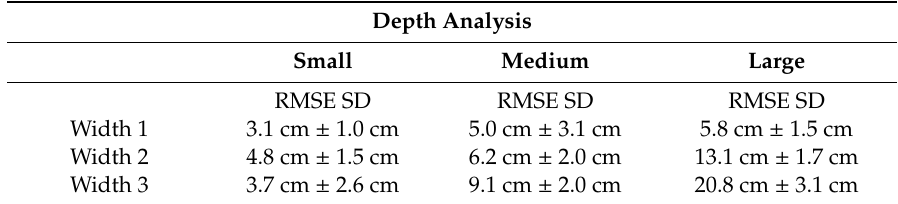
Table 4. Depth analysis in which data was captured at 2.5 cm cross-line spacing using a VV polarization for roots that were vertical to surface and perpendicular to scan direction. This was done for the three size classes of small, medium, and